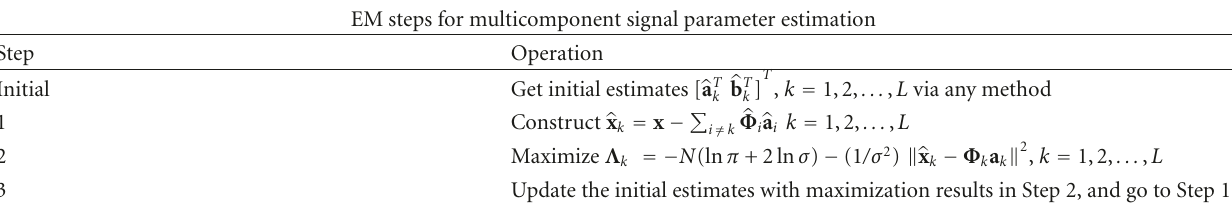
Table 5: Expectation Maximization (EM) iteration